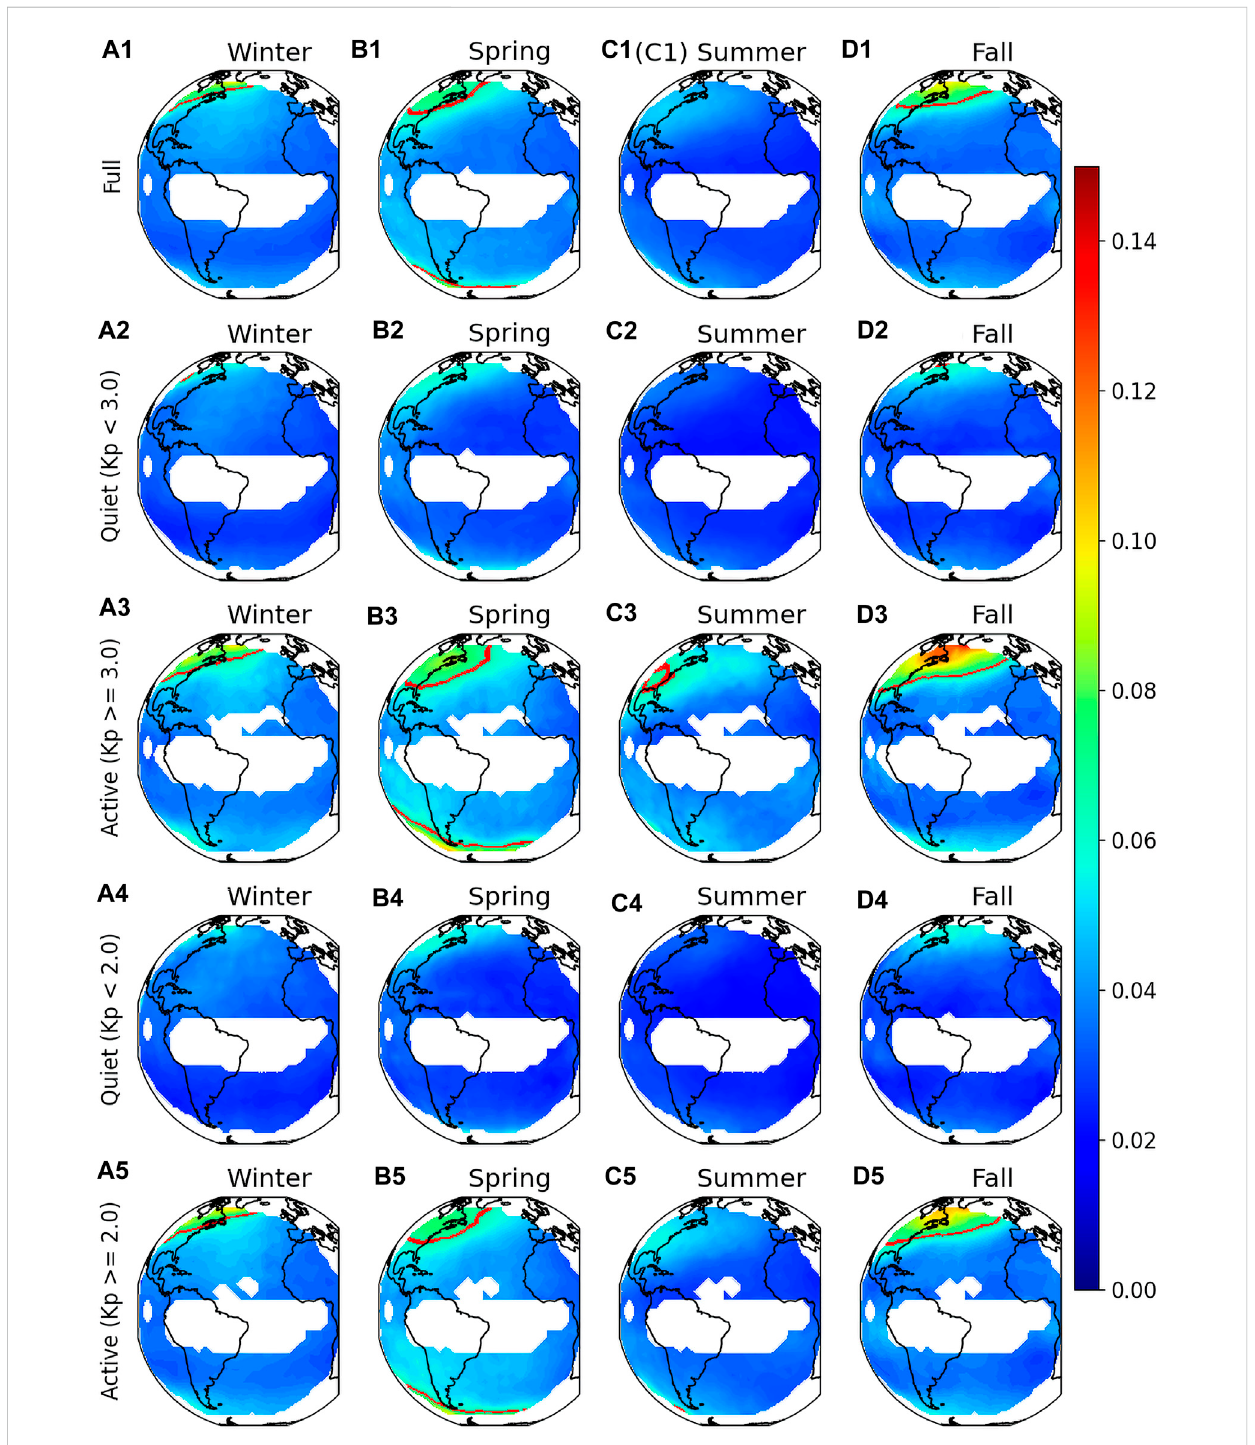
FIGURE 2 (A1 – D1) AbsolutestdsofO/N 2 ratiosforthefourseasonsusingallreliabledata. (A2 – D2) , (A3 – D3) , (A4 – D4) and (A5 – D5) arethesameexceptforthe stdscalculatedusingdatawithKp < 3.0,Kp ≥ 3.0,Kp < 2.0andKp ≥ 2.0,respectively.BlankareasareregionswheremorethanhalfofthedailyO/N 2 points had uncertainties exceeding 0.30. Red lines are the contours of